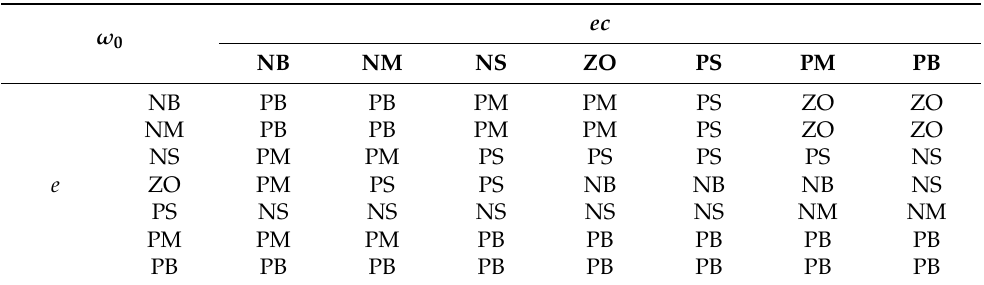
Table 3. Fuzzy rules for ω 0 .